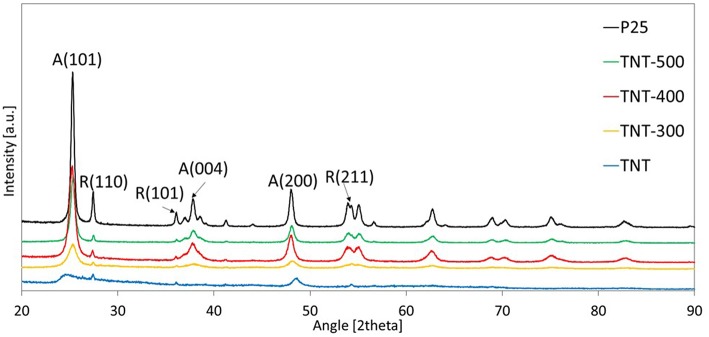
XRD patterns of different samples. The most important planes are indicated.